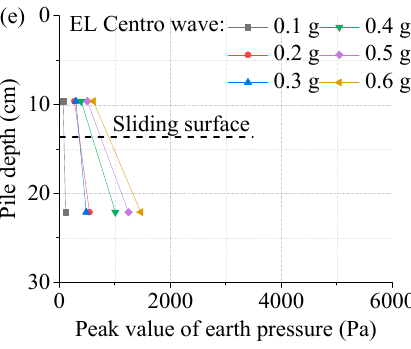
Figure 14. Distribution of peak earth pressure in di ff erent sections. ( a ) Behind back-row anti-slide piles; ( b ) front side of back-row anti-slide piles; ( c ) behind bridge foundation; ( d ) front side of bridge foundation; ( e ) behind front-row anti-slide